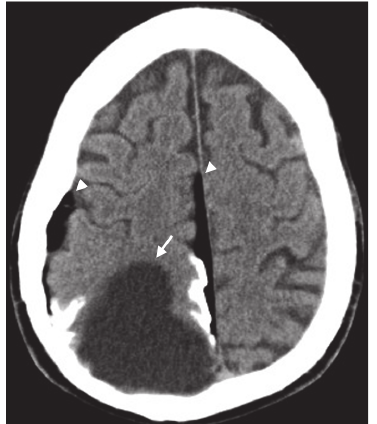
Figure 2: Noncontrast CT brain with a large right posterior parietal porencephaliccystwithadjacentcorticalcalcification(arrow).There is intracranial fat tracking along the falx and subjacent to the right parietal bone (arrowheads).